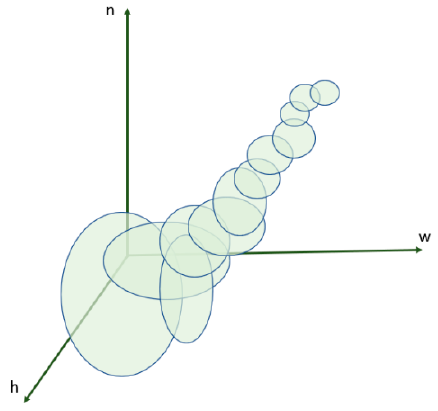
Figure 4. PGA filtering process in Genetic Algorithm application.